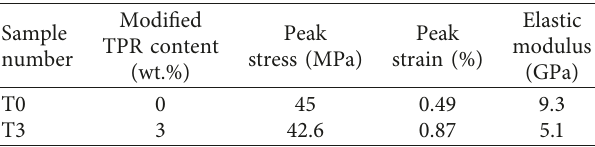
Figure 11: Stress-strain curves of pure cement sample and 3% TPR cement stone. Table 3: Test results of stress and